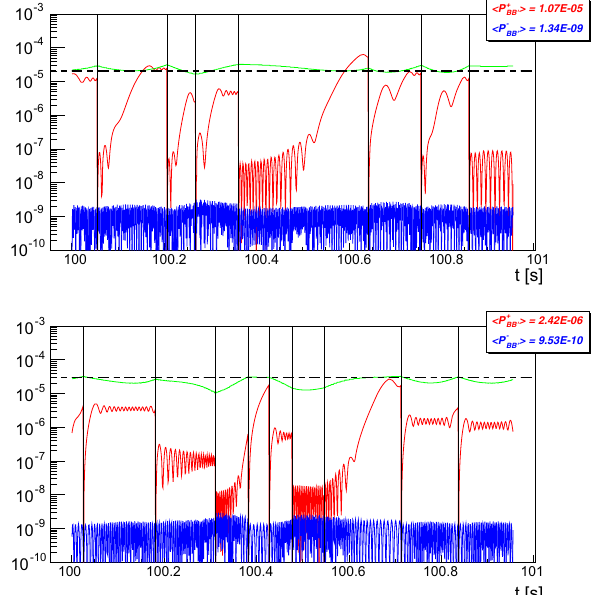
Fig. 3 Examples of time evolution of n − n (cid:2) oscillation probabilities ( t ) (4) between wall scatterings for an UCN with v = 4 m/s. P ± BB (cid:2) For definiteness, the central field is taken as B c = 0 . 21 G and n − n (cid:2) oscillationtimeissetas τ = 10s.Mirrorfield(shownbyhorizontaldash lines in Tesla units) is taken as B (cid:2) = 0 . 2 G (upper panel) or B (cid:2) = 0 . 3 G (lower panel). Green curves show the profile of applied magnetic field (also in Tesla) which the neutron crossed during its diffusion in the trap. Red and blue curves correspond to P + ( β = 0) and P − ( β = π ). At BB (cid:2) BB (cid:2) each wall scattering (marked by black vertical lines) the wave function resets to the pure neutron state. In insets we show the corresponding average probabilities per wall